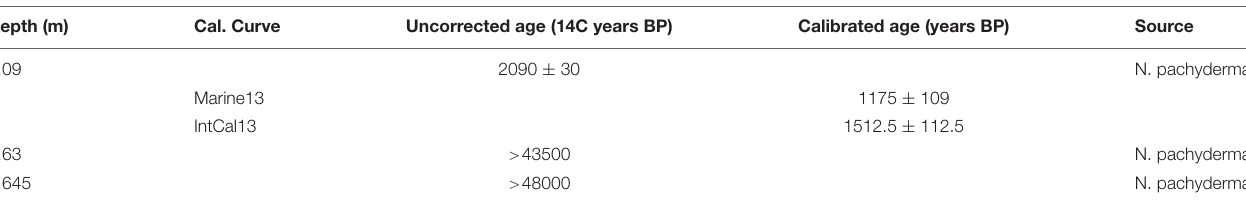
FIGURE 8 | Correlation of sediment cores HLY0503-8JPC (8JPC) and SWERUS-13PC (13PC; c.f., Figure 1 for core locations) based in the positions of brown layers B1 and B2. Locations of brown layers in 8JPC is based on Schreck et al. (2018) and the correlation presented in Figure 7 for 13PC. Parameters shown are calcium (Ca), manganese (Mn) and characteristic remanent magnetisation (ChRM) inclination. (A) Parameters for 8JPC with the location of marine isotope stage (MIS) boundaries and locations of brown and grey layers. (B) Parameters for 13PC with characteristic remanent magnetisation (ChRM) inclination and fuzzy c-means cluster (FCM) results from physical (SC) and magnetic (MC) properties. Position and age of three radiocarbon ages (uncorrected ages; 14 C yrs BP) are shown as red triangles. TABLE 1 | Radiocarbon ages for